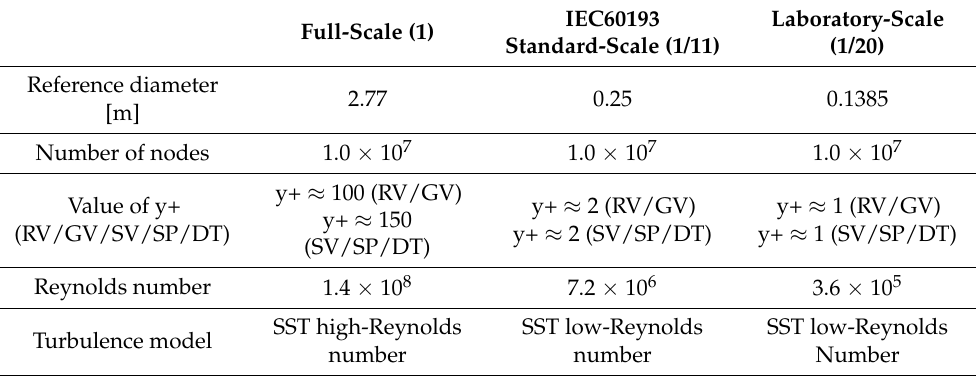
Figure 4. Monitoring points in the computational domain and experimental setup: Positions of monitoring points in the ( a ) computational domain and ( b ) experimental setup. Table 1. Number of nodes for the main components.